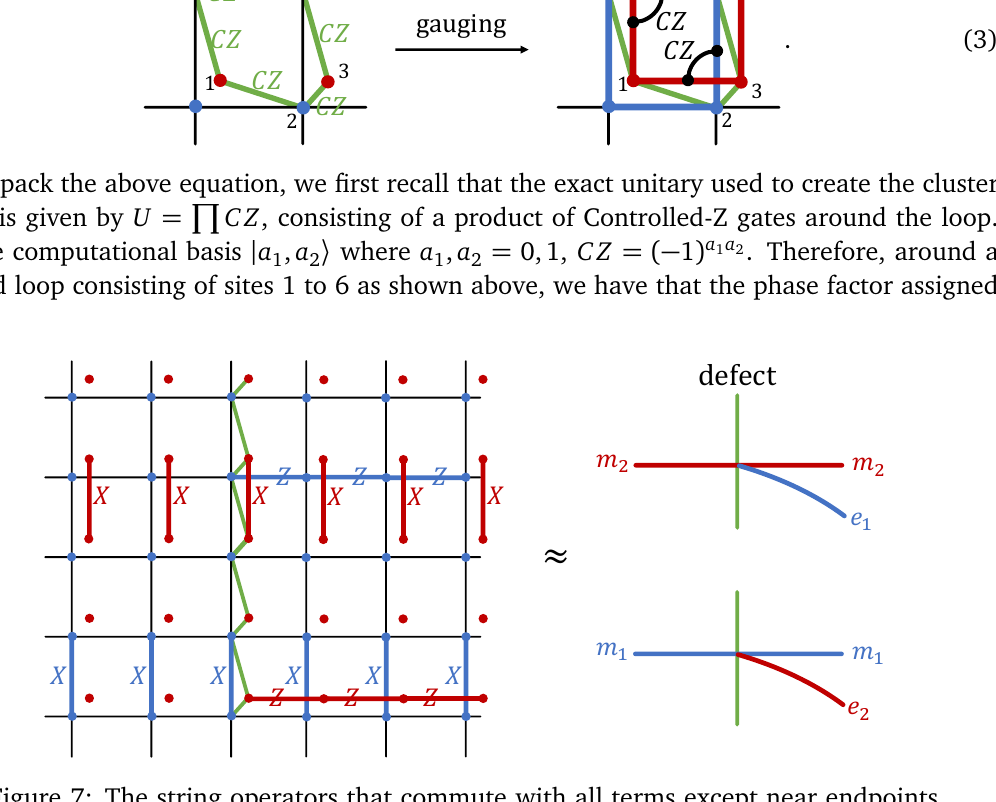
Figure 7: The string operators that commute with all terms except near